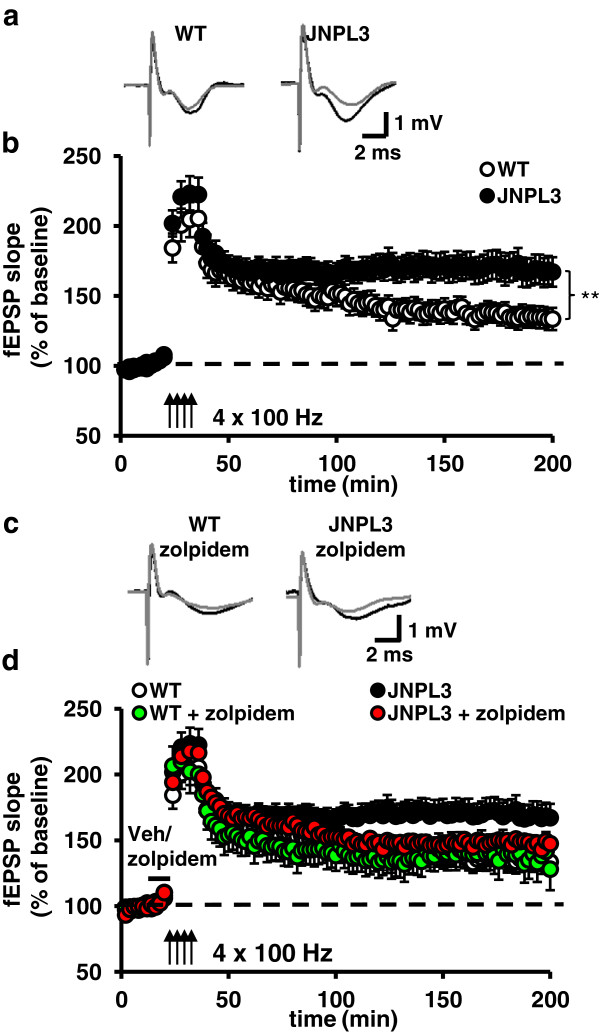
Aged Tg mice exhibit altered synaptic plasticity which can be rescued with zolpidem, a GABAAR agonist. (a) Representative traces of field excitatory postsynaptic potentials (fEPSP) in hippocampal slices from aged JNPL3 (BL6) and WT mice that received four trains of high frequency stimulation (HFS) (gray = fEPSP at baseline, black = fEPSP after HFS). (b) Late-phase long-term potentiation (L-LTP) is enhanced in aged JNPL3 (BL6) mice compared to WT controls (ANOVA: WT= 9 mice, 24 slices; Tg=12 mice, 28 slices, F(1,50)=7.841, **p=0.007). (c) Representative traces of fEPSPs in slices from aged JNPL3 (BL6) and WT mice treated with the GABAAR agonist zolpidem and four trains of HFS (gray = fEPSP at baseline, black = fEPSP after HFS). (d) Zolpidem (1 μM for 10’) rescued the enhanced L-LTP in Tg mice while having no effect on L-LTP in WT slices (ANOVA: WT zolpidem=6 mice, 11 slices, Tg zolpidem=7 mice, 17 slices, WT veh= 9 mice, 24 slices, Tg veh=9mice, 28 slices, F(1,78)=6.841, *p=0.011. Tukey HSD comparison: Tg zolpidem vs. WT veh: p=0.971). Data presented as mean ± SEM.